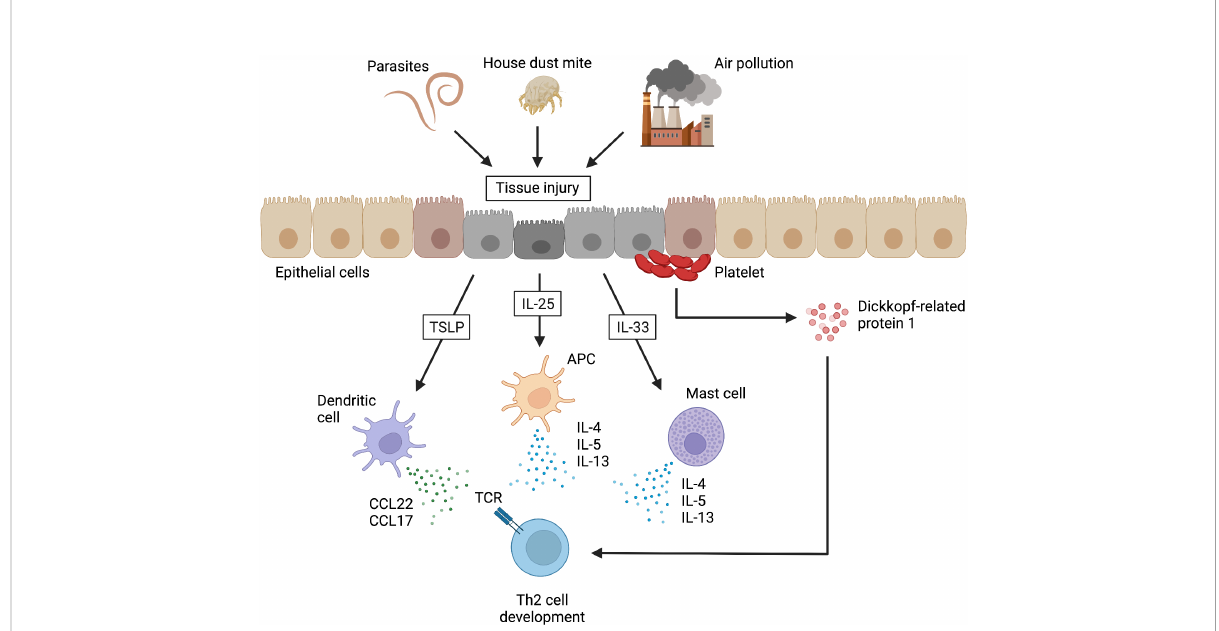
FIGURE 1 Alarmins that induce Th2 cell development in non-lymphoid tissues. When airway epithelial tissues are damaged by helminth infections, house dust mites, or air pollution, the damaged epithelial cells release alarmins (e.g., thymic stromal lymphoid neoplastic factor [TSLP], interleukin [IL]- 25, and IL-33). TSLP activates local dendritic cells to secrete CC chemokine ligand 22 (CCL22) and CCL17, which promote the development of type 2 helper T (Th2) cells. IL-25 induces the production of IL-4, IL-5, and IL-13 from antigen-presenting cells (APCs), resulting in the promotion of Th2 cell development. IL-33 also promotes Th2 cell development by inducing the production of Th2 cytokines from mast cells. In addition, Dickkopf-related protein 1, which is a Wnt antagonist released from platelets at the site of injury, can similarly promote Th2 cell development. TCR, T cell receptor. This fi gure was created with